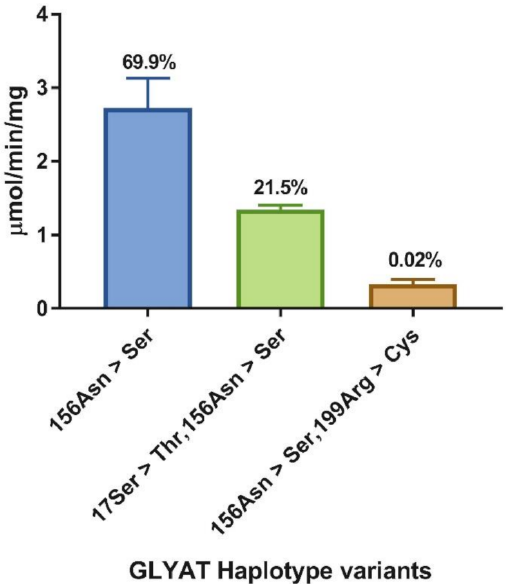
Figure 4. Relative enzyme activity of glycine N -acyltransferase (GLYAT) haplotypes 156Asn > Ser, 17Ser > Thr,156Asn > Ser and 156Asn > Ser,199Arg > Cys. Assays were performed in triplicate with 2 µ g protein, 20 mM glycine, and 80 µ M benzoyl–CoA. The standard deviation is shown by the error bars and the haplotype frequencies are indicated above each